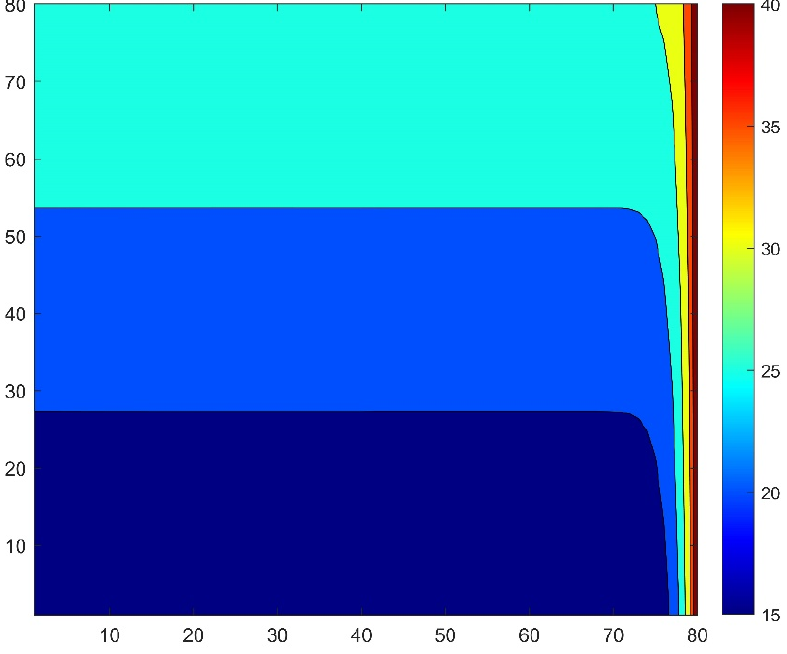
Figure 17. The temperature distribution contour for equidistant mesh in the case of a wall with insulation.